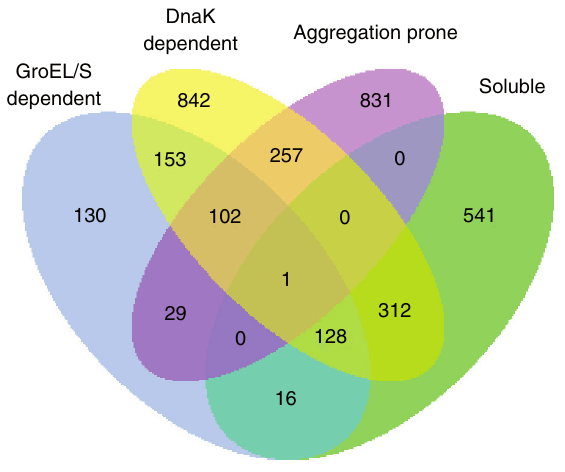
Figure 1. Integration of independent studies. A Venn diagram of proteins of E. coli identified by different experimental studies shows that ~45% of soluble proteins reported by Niwa et al. overlap with GroEL/S or DnaK substrates (soluble proteins are defined as having solubility >70% and aggregation-prone proteins have solubility